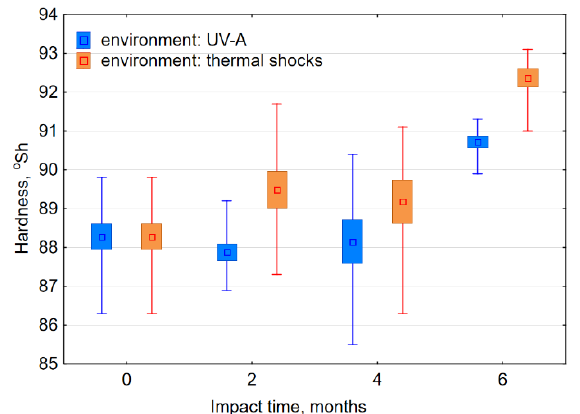
Figure 18. Average hardness of the samples after assumed weathering periods. The error bars mark the values of average standard deviation values of particular data series.